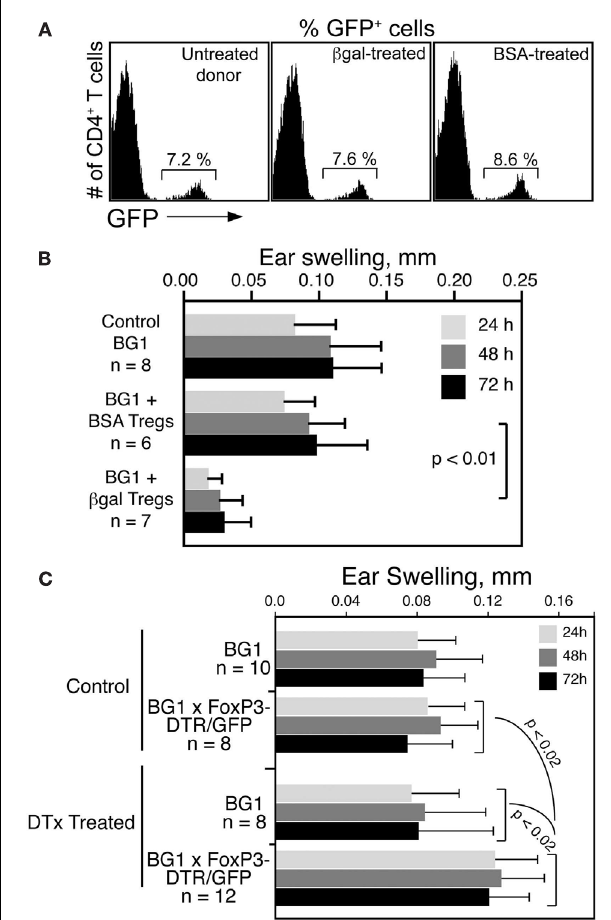
FIGURE 4 | Retinal expression of β gal in the BG1 × arr β gal mice leads to an inhibited DTH response to β gal. None of the mice were immunized; all were naive and unmanipulated. Ear swelling was induced as described in the Section “Materials and Methods.” All results are given as mean ± SD with P values determined by t -test.